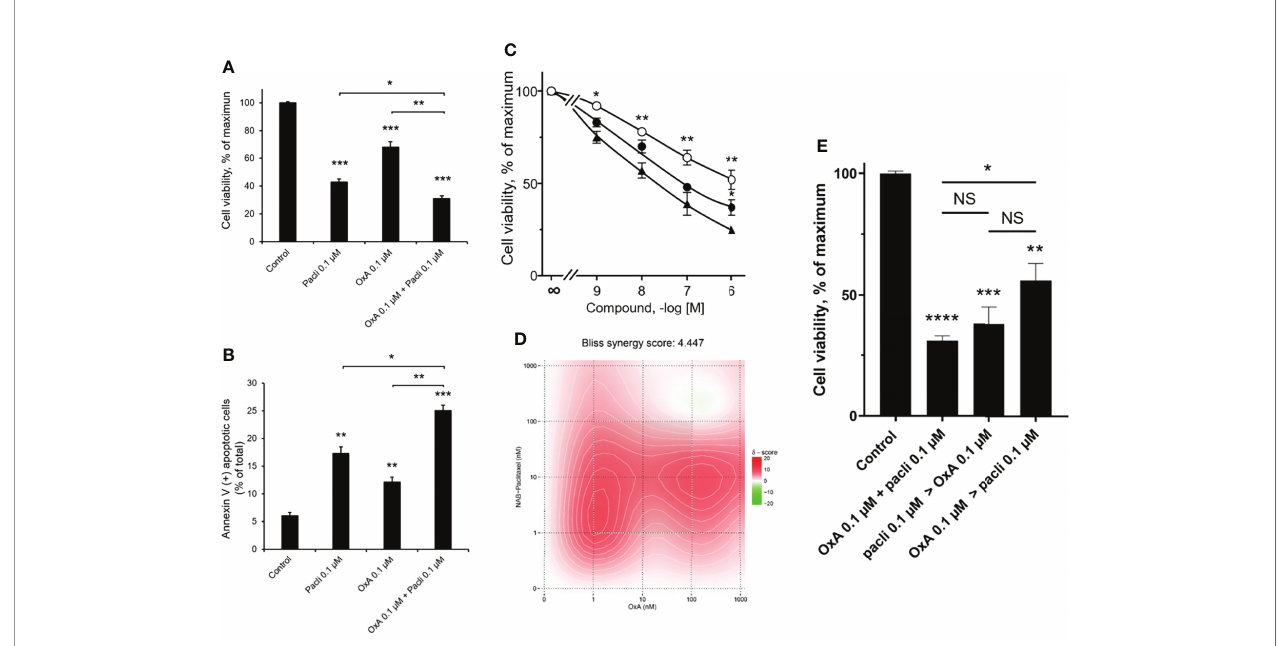
FIGURE 2 | Inhibition of AsPC-1 cell growth by OxA and/or Nab-paclitaxel. (A) Inhibition of AsPC-1 cell viability induced by 0.1 µM Nab-paclitaxel (pacli), 0.1 µM OxA (OxA), or 0.1 µM Nab-paclitaxel plus 0.1 µM OxA. Results were expressed in the percentage of maximum obtained in the absence of treatment (control). (B) Effect of OxA or Nab-paclitaxel or their addition on apoptosis of ASPC-1 cells. Apoptosis was determined by annexin V/7-AAD binding, and results were expressed as the percentage of apoptotic cells. (C) Effect of the dose – response of OxA or Nab-paclitaxel or OxA plus Nab-paclitaxel on cell viability of AsPC-1 cells. (D) Bliss model diagram and estimation of Bliss synergy score. (E) OxA plus Nab-paclitaxel treatment and Impact of sequential treatment by OxA>Nab-paclitaxel or Nab- paclitaxel>OxA compared to control (absence of treatment). Results were expressed in the percentage of maximum obtained in the absence of treatment. Data were the means ± SEM of three separate experiments. ( ○ ) OxA, ( ● ) Nab-paclitaxel, and ( ▲ ) OxA plus Nab-paclitaxel. NS, non-signi fi cant, *p<0.05, **p<0.01, ***p<0.001, and ****p<0.0001 corresponding to comparison with